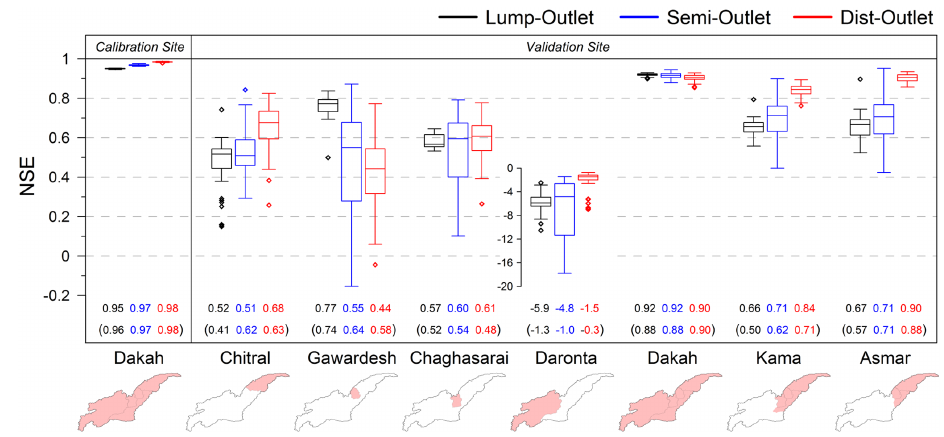
Figure 8. Comparison of the basin outlet calibrations for the three parameterizations of lumped, semi-distributed, and distributed. Each calibration is conducted 50 times. Values on the bottom represent expected values of NSE (in upper row) and KGE (within parenthesis in lower row) from 50